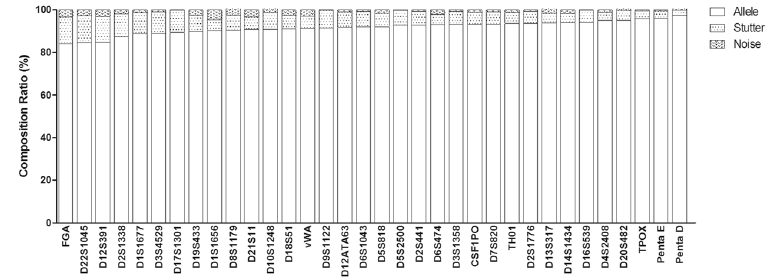
Figure 1. The allele/noise/stutter ratios at the 34 STRs with the double sequencing reads from the 200